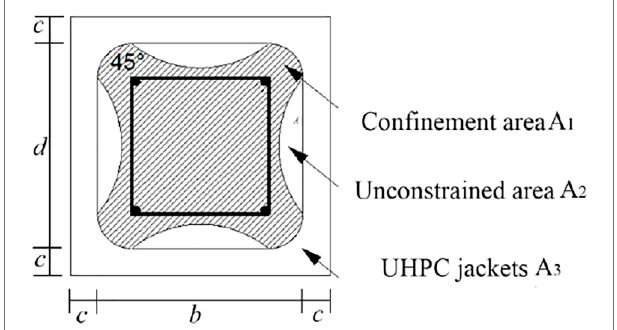
FIGURE 12 | Schematic diagram of the constraint model of the UHPC retro fi tting layer.